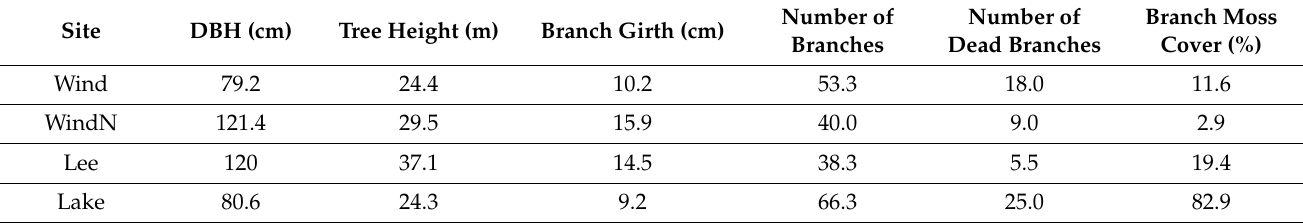
Table 2. Host-tree characteristics (averaged over five sample trees) at each of the four